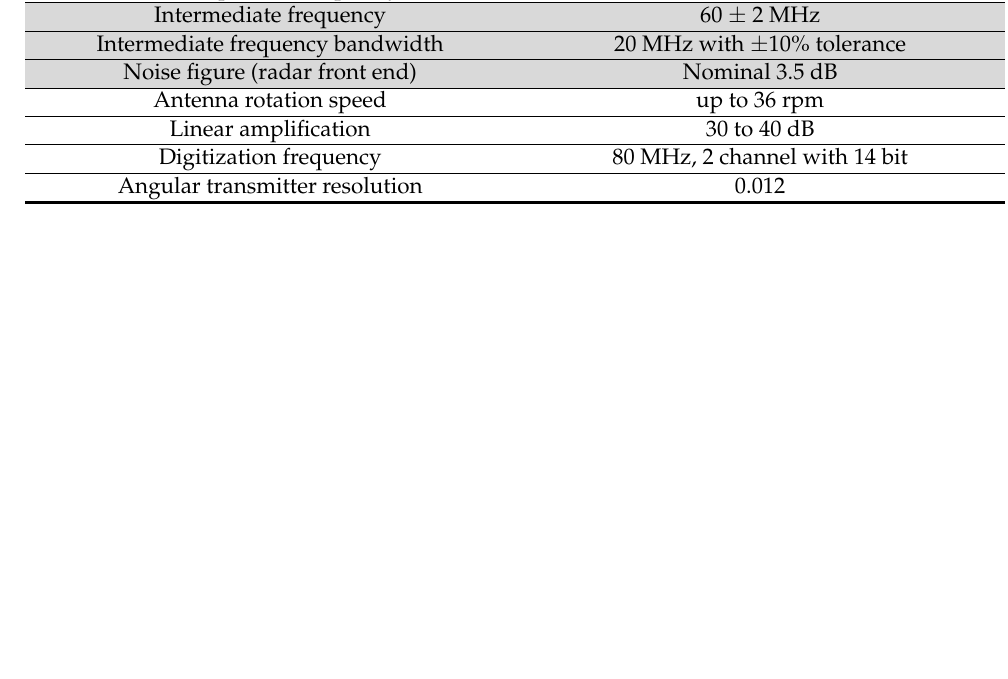
Figure 2. Block diagram of HZG’s coherent on receive MR. All grey shaded boxes are original units from the GEM radar; all white boxes represent custom made add ons to the system. Since 2011, the radar system is based on the radar scanner SU70-14E from GEM elec- tronica, which operates in X-band (9.4 GHz) with a peak power of 12 kW. For METOC applications the radar is operated with a short pulse (50 ns) representing a range resolu- tion of 7.5 m and a pulse repetition frequency of up to 2 kHz. The radar system is operated with a dedicated software with a graphical user interface running on a standard Win- dows-PC that is also used to store and process the acquired data. The internal control of the scanner unit is handled by the original communication board as well as a custom made control board designed in close collaboration with St. Petersburg Electrotechnical Univer- sity, Russia. The communication board gets its information from the PC as well as the main control board. It controls the warm up cycle, switching between transmission and standby as well as the tuning of the modulator. Furthermore, it provides the PC and con- trol board with information on the power to the magnetron and the coarse tuning quality. The control board triggers the modulator and ADC. It also converts the incoming stream of every pulse from the ADC into a complex numbered string, which is sent via LAN to the PC for storage of the data. In addition, the control board controls the motor responsible for the azimuthal pointing of the antenna. Two different antenna operations have been